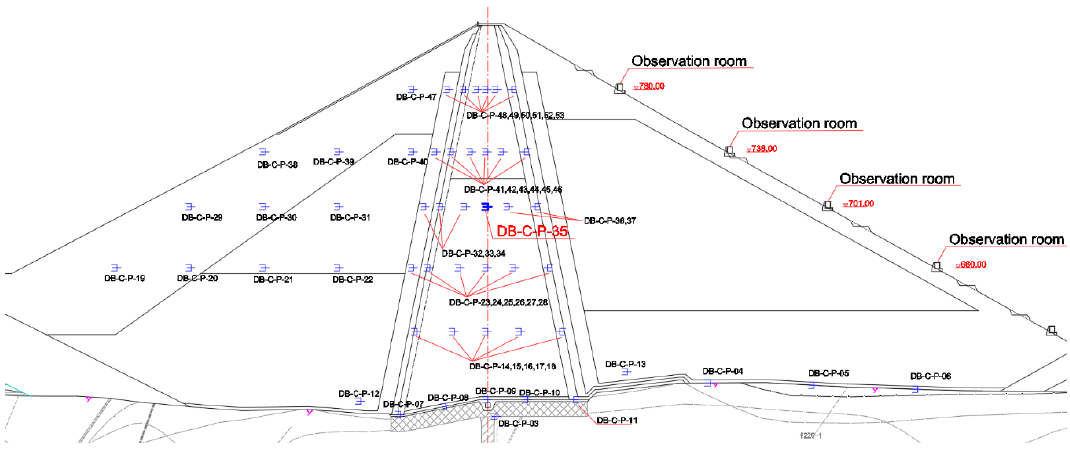
Figure 2. Schematic diagram of osmometer layout of the C section.